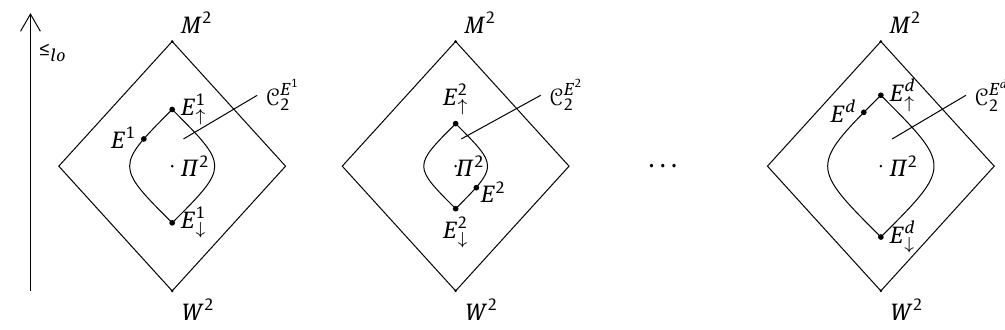
E i } of bivariate copulas generated by the copulas E i ∈ C 2 , i = 1, . . . , d , via the Figure 4 Classes C E i 2 = { C ∈ C 2 | C ≤ ∂ 2 S ≤ -ordering. Note that M 2 , Π 2 , and W 2 denote the upper Fréchet copula, the independence copula, and the lower Fréchet ∂ 2 S copula, respectively. The copulas E i and E i are the uniquely determined copulas that are CIS and CDS, respectively, such that ↑ ↓ = , see Proposition 3.17. As a consequence of Proposition 3.14, it holds for all D ∈ C E i i = i E i ∂ 2 S E ∂ 2 S E ↑ ↓